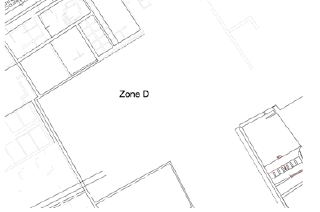
Figure 13 . Plan of the zone D (© Ychsma Project 2018) By looking only at the photogrammetric data, the